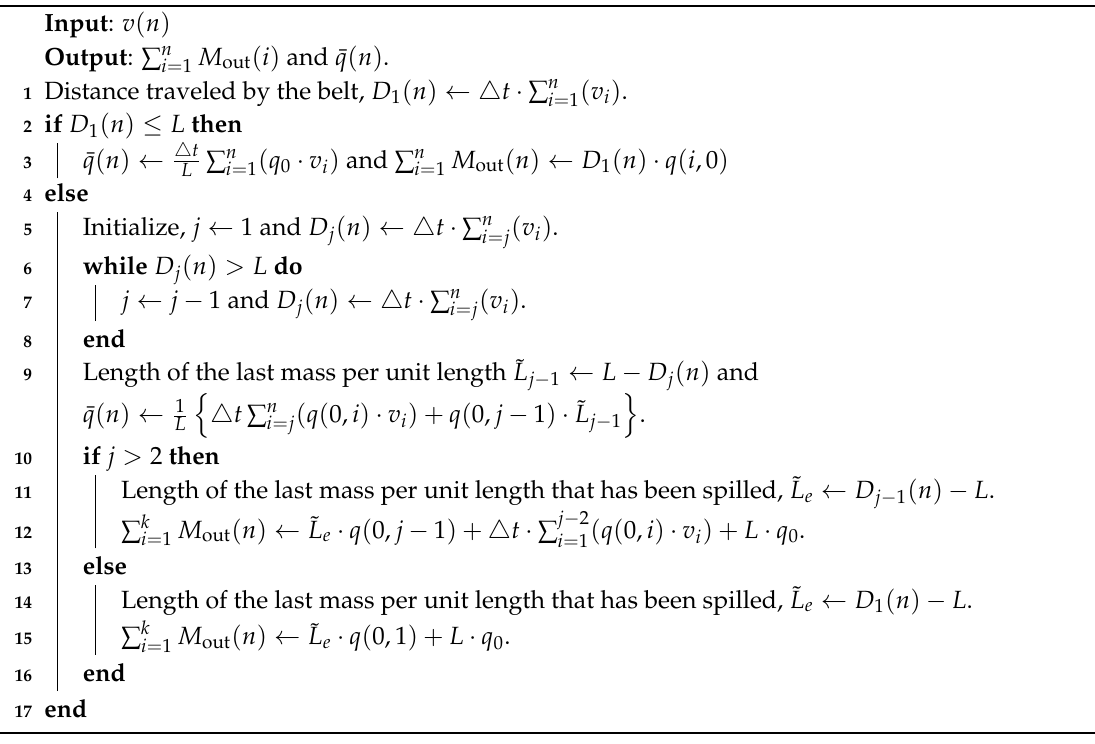
Figure 7. Three-dimensional view of q ( x , t ) on the 8 km-long conveyor. Algorithm 1: Calculating the actual average mass per unit length and total amount of material